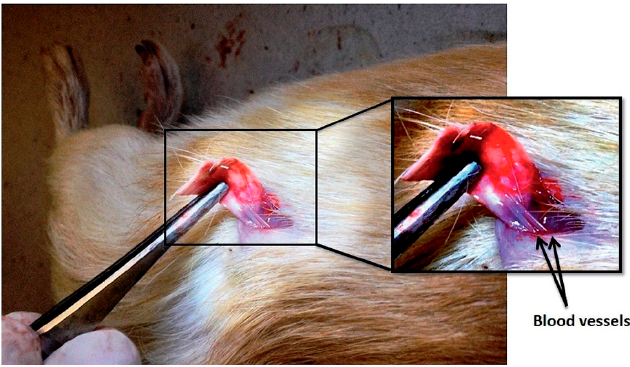
Figure 21. Matured blood vessel through the implanted polycaprolactone scaffolds containing 1 wt % ZnO nanoparticles after 20 days of subcutaneous implantation. Reproduced with permission from reference [23]. Copyright (2014) Royal Society of Chemistry.